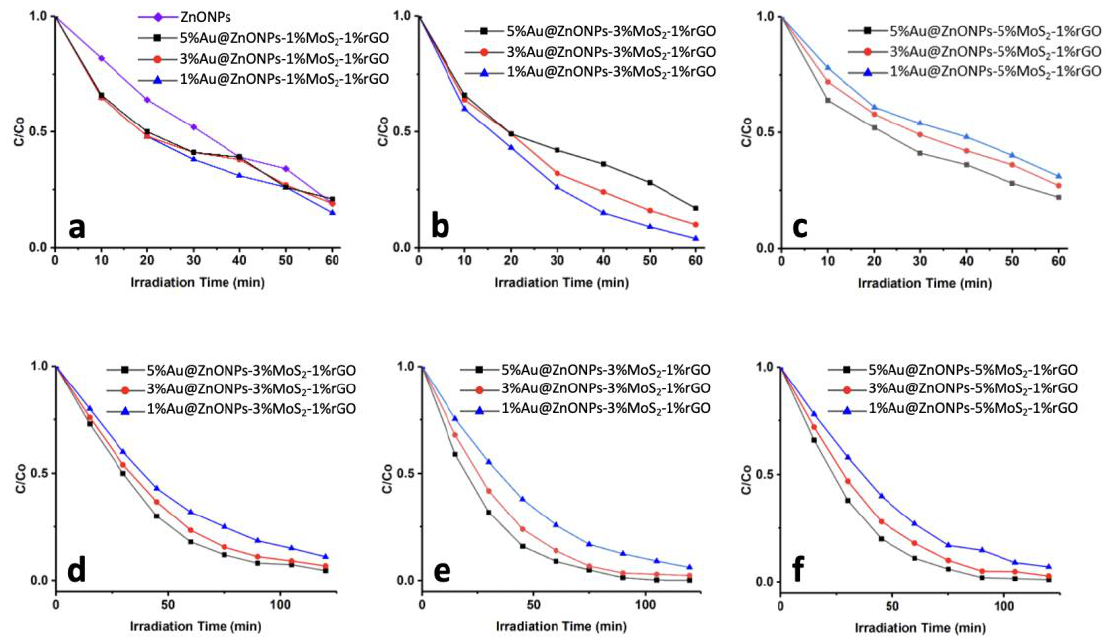
Figure 7. Photodegradation rates of the antibiotics CFX ( a – c ) and LFX ( d – f ) as a function of time by the different synthesized catalysts.